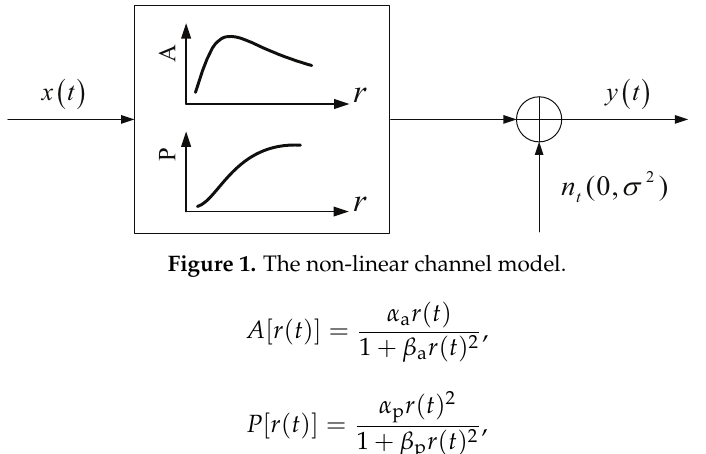
Figure 1. The non-linear channel